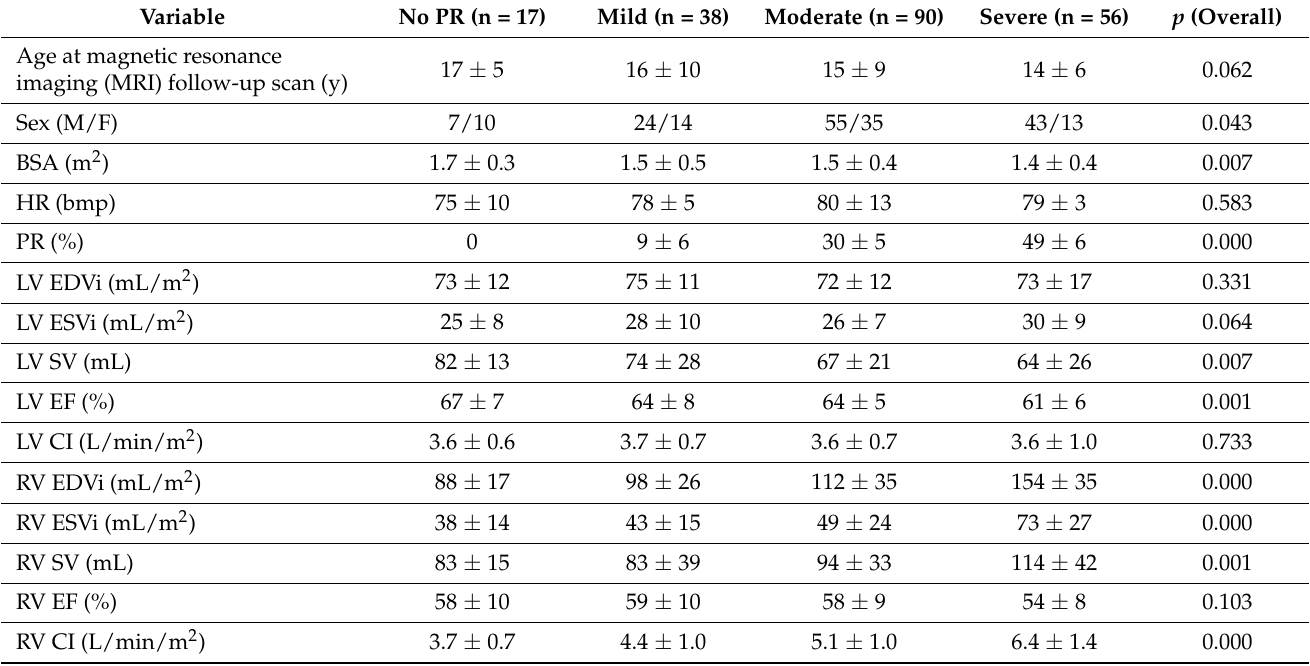
Table 1. Summary of demographic data and CMR data comparing groups of patients with four differing levels of severity of pulmonary